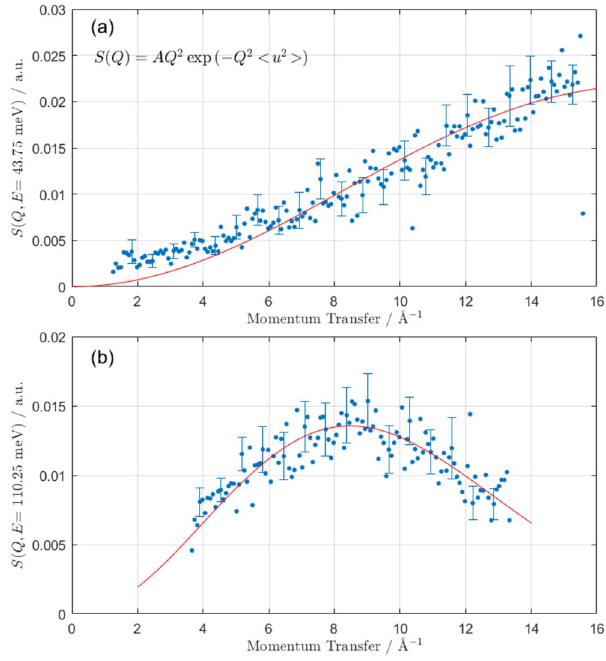
Figure 6. Example S ( Q ) for two particular energy cuts (panel (a), 43.00–44.50 meV and panel (b), 109.50– 111.00 mev), with fit to Equation 5. Qualitatively, S ( Q ) in panel (b) is attenuated more strongly in Q due to the larger Debye-Waller factor of the atoms participating in motion at that